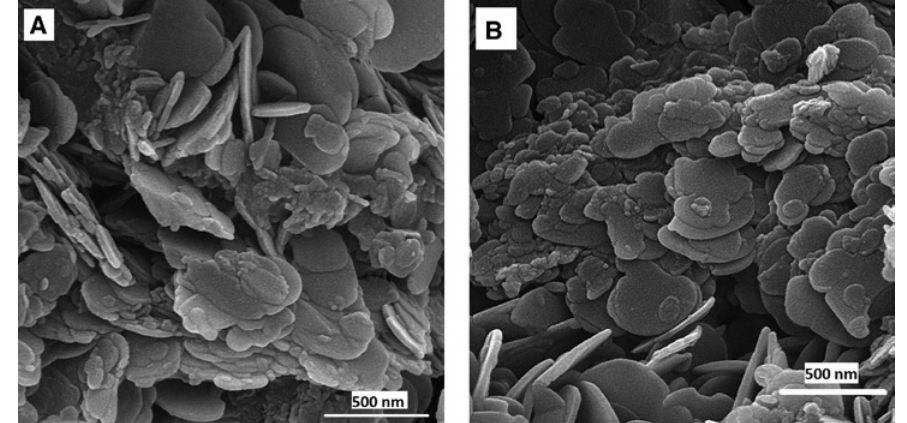
Figure 7: SEM of (A) MgO-2 and (B)